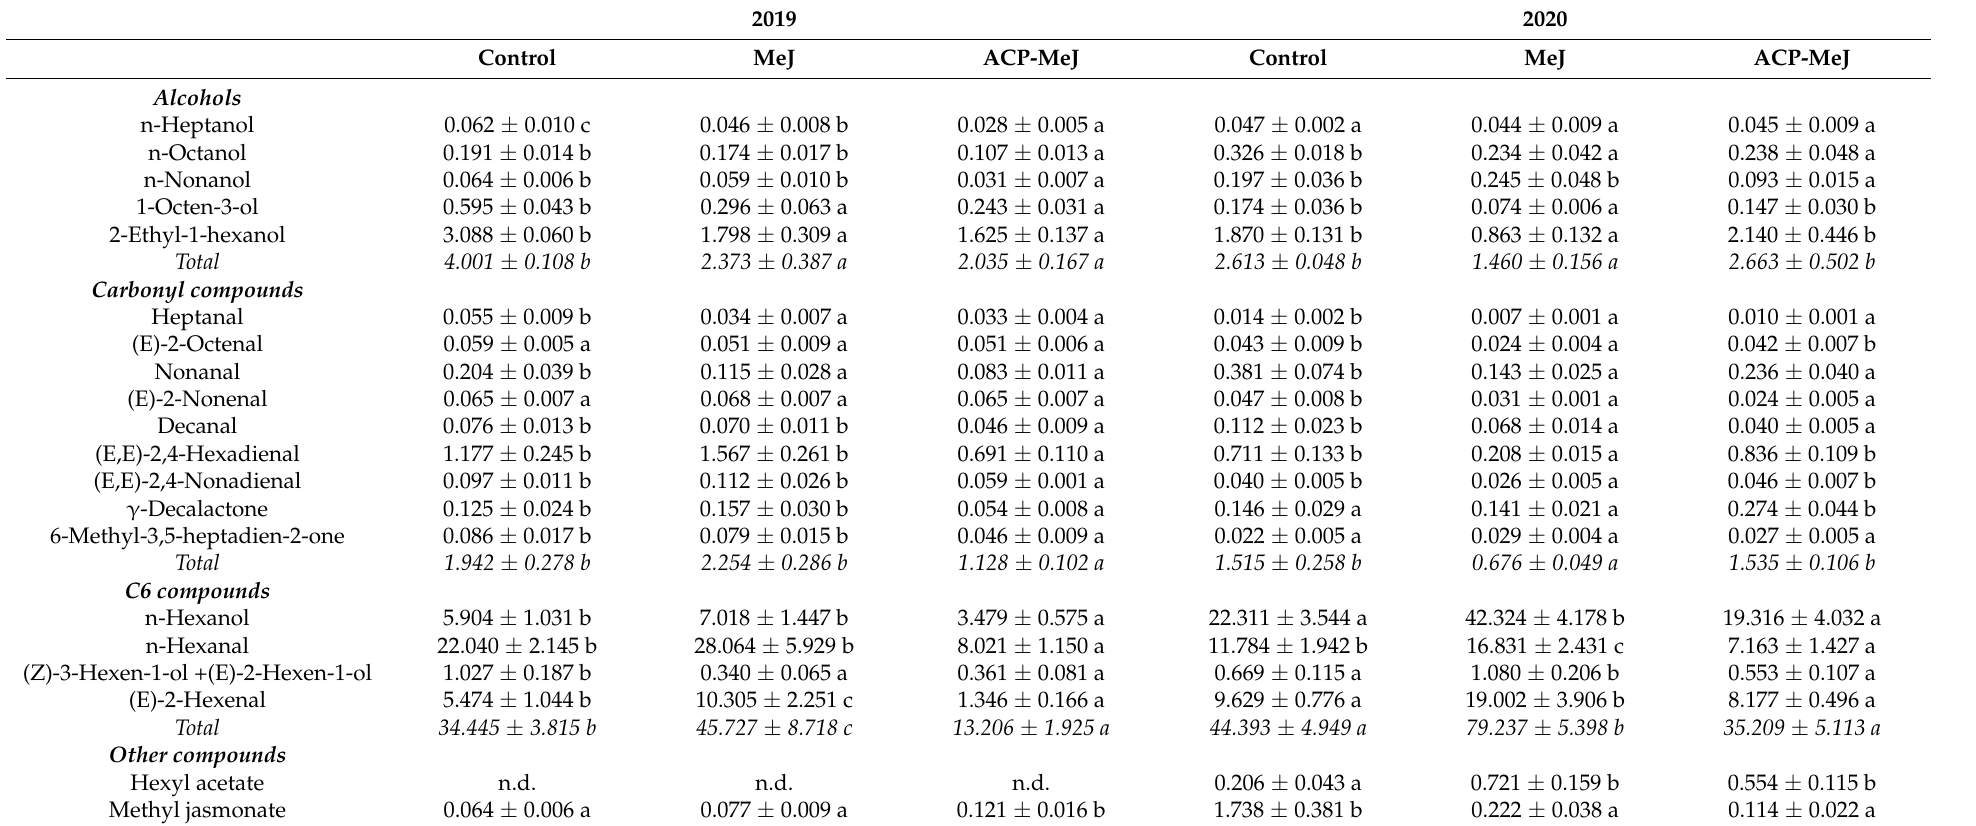
Table 2. Alcohols, carbonyl compounds, C6 compounds and other compounds concentration ( µ g/L) in grapes from control, methyl jasmonate (MeJ) and nanoparticles doped with MeJ (ACP-MeJ) foliar treatments, in 2019 and 2020